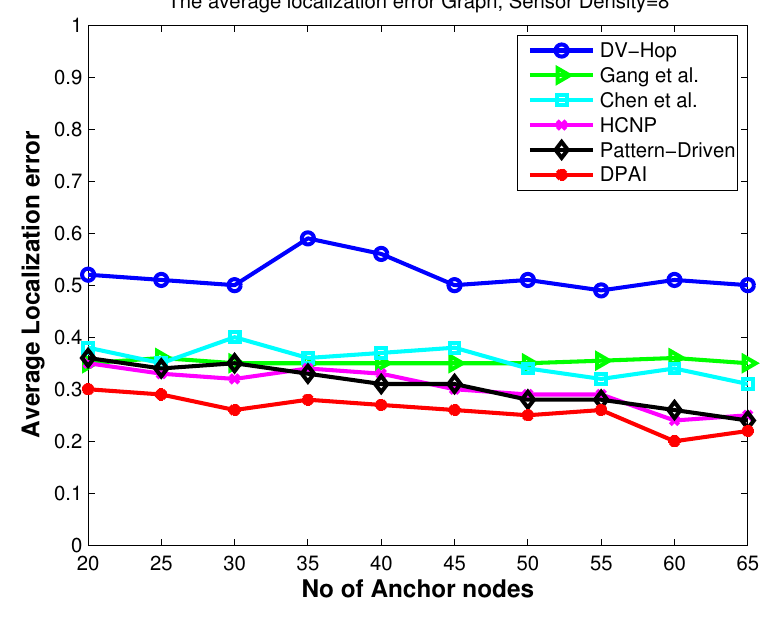
Figure 4. Location error vs . number of anchor nodes (isotropic network).